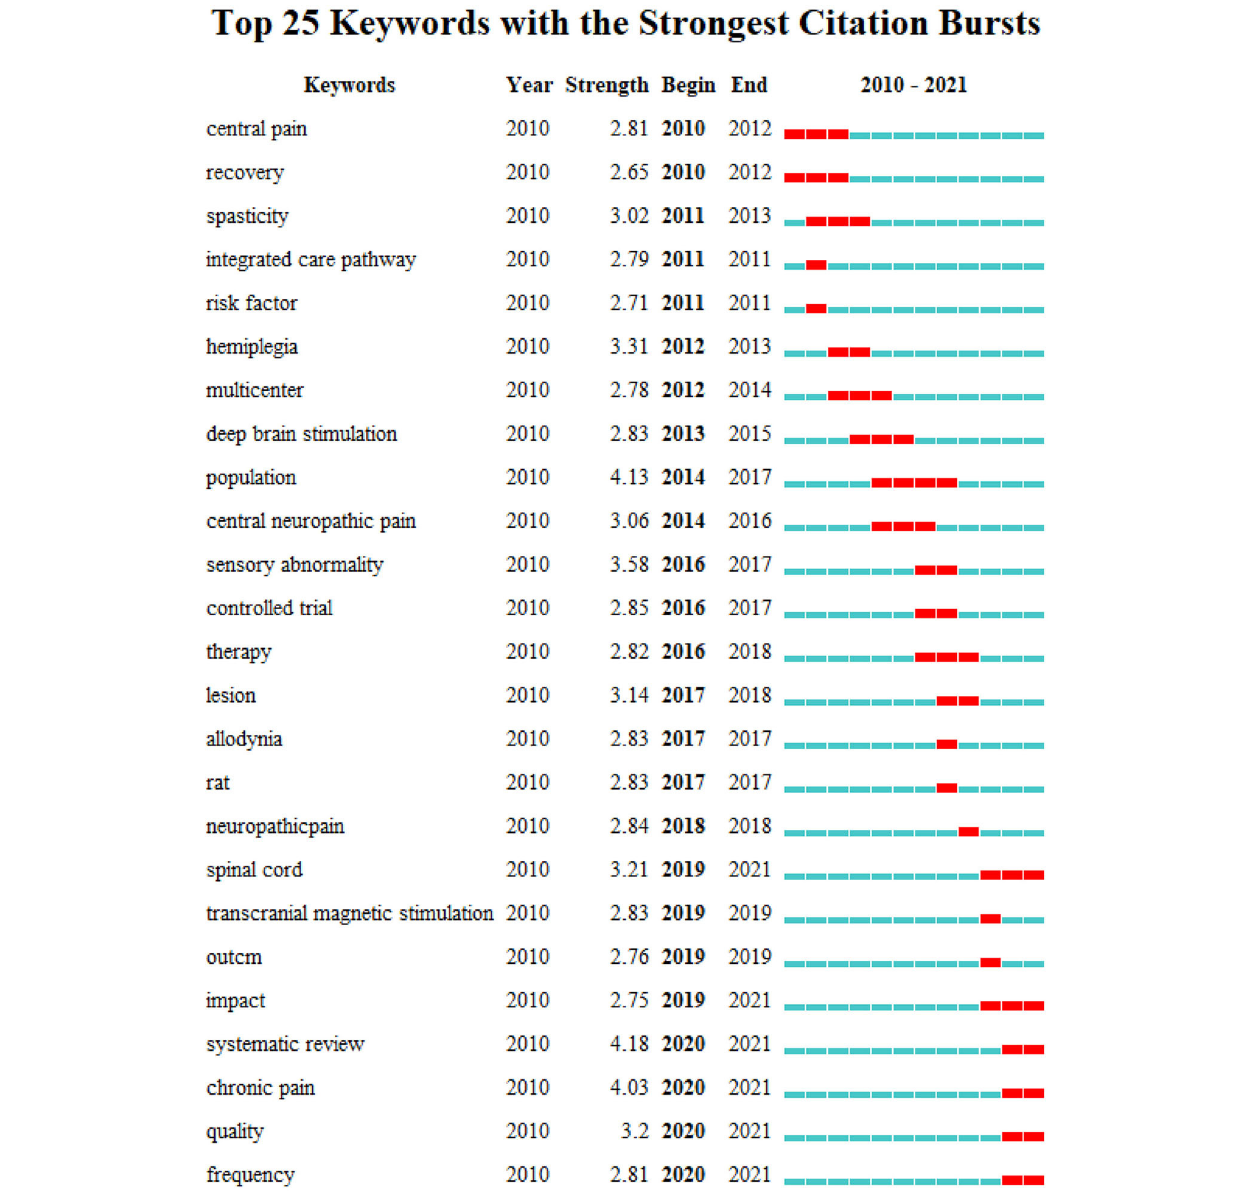
nonpharmacological (passive range-of-motion exercises et. al) interventions (Dyer et al., 2020; Souza et al., 2021). In recent years, noninvasive brain stimulation has been proven as a potentially effective intervention to relieve shoulder pain after stroke (Choi and Chang, 2018; de Souza et al., 2019). CPSP is a type of central neuropathic pain. While the pathophysiology of the occurrence of CPSP has not yet been elucidated, some possible mechanisms include hyperexcitability of the spinothalamic tract and central sensitization (Park et al.,